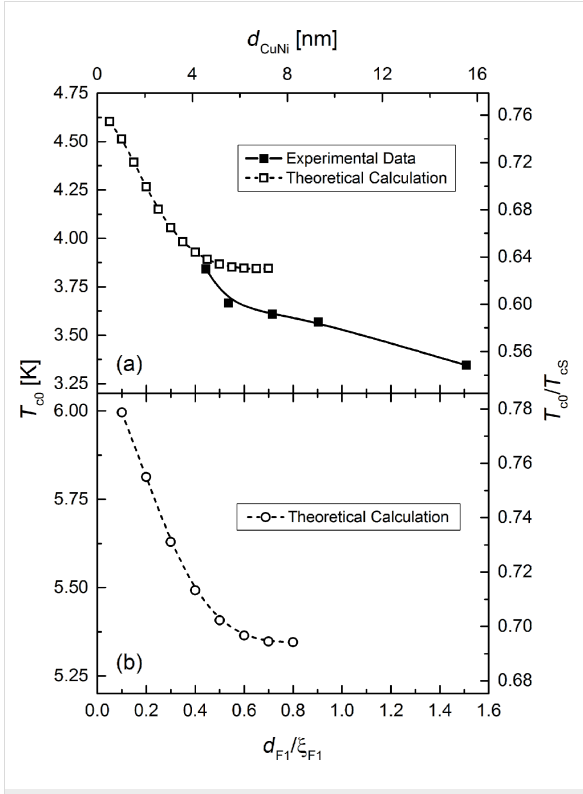
Figure 8: Superconducting transition temperature, T c0 , in zero external magnetic field as a function of the F 1 = Cu 41 Ni 59 layer thickness d F1 = d CuNi . While the solid squares in (a) show experimental results, the open squares and circles in (a) and (b), respectively, show predic- tions, which can be derived from the theory of Fominov and co-workers [15]. The solid and dashed lines are guide to the eye. The theoretical data are plotted both in absolute and normalized (with respect to T cS ) units. In (a), we assumed T cS = 6.1 K, in (b) we used T cS = 7.7 K, which is the critical temperature of a free standing Nb film of 12 nm thickness. Moreover, we used ξ F1 = 10.3 nm for the magnetic coher- ence length in the F 1 layer (Cu 41 Ni 59 layer) to plot the data as a func- tion of the reduced thickness d F1 / ξ F1 . For a detailed discussion of the material and modeling parameters used for the theoretical calculations, see the